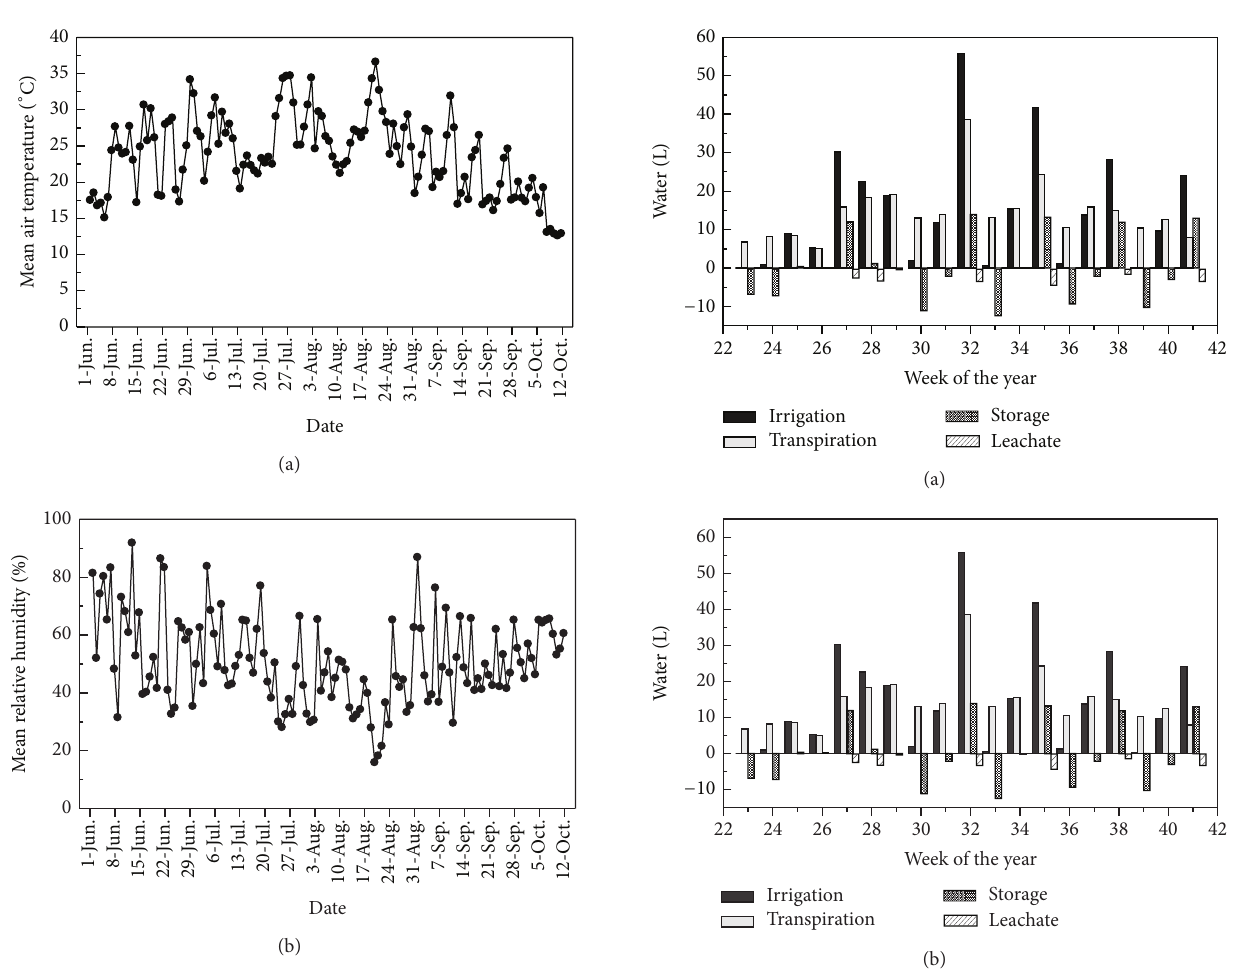
Figure4:Meanoftheweeklyexperimentalwaterbalancecalculated throughout the vegetation